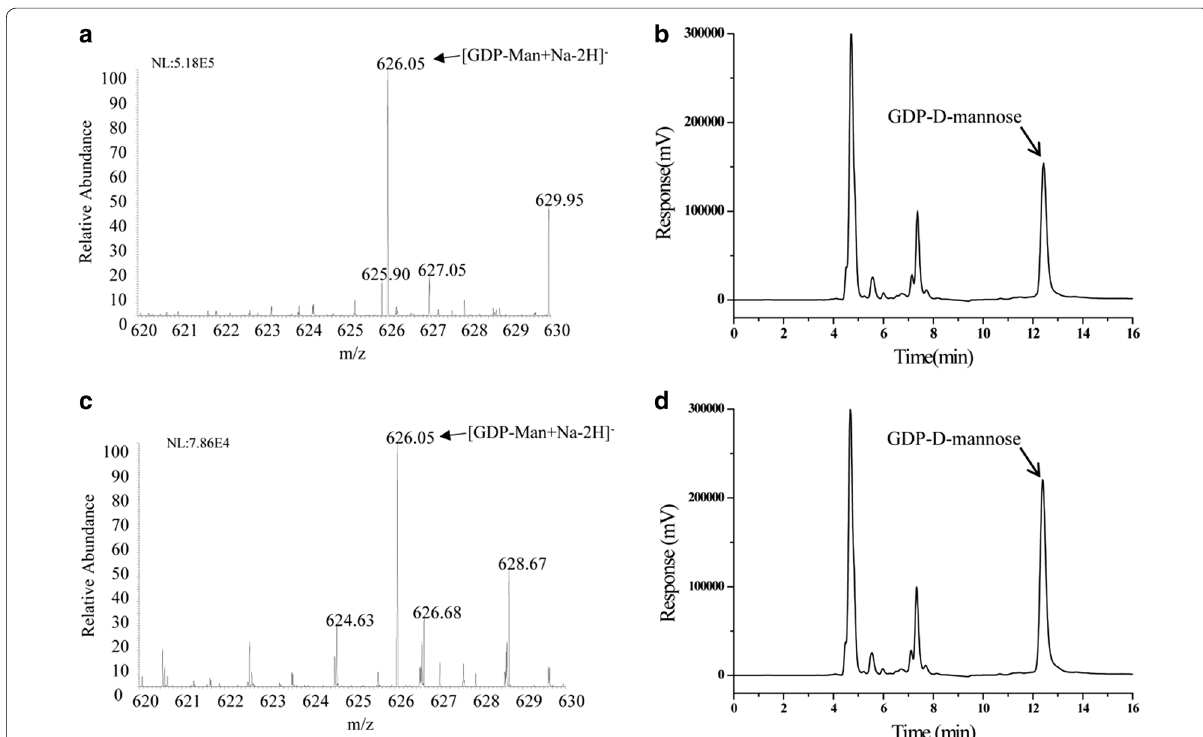
Fig. 4 MS ( a ) and HPLC ( b ) analysis of the production of GDP- d -mannose by two-step method. Glk was firstly added into the reaction sample and incubation for 10 h, after terminating the reaction by heating, ManB and ManC were simultaneously supplied to the reaction sample for production of GDP- d -mannose. MS ( c ) and HPLC ( d ) analysis of the production of GDP- d -mannose by one-step method. Glk, ManB and ManC were simultaneously added into the reaction sample for conversion of mannose to GDP- d